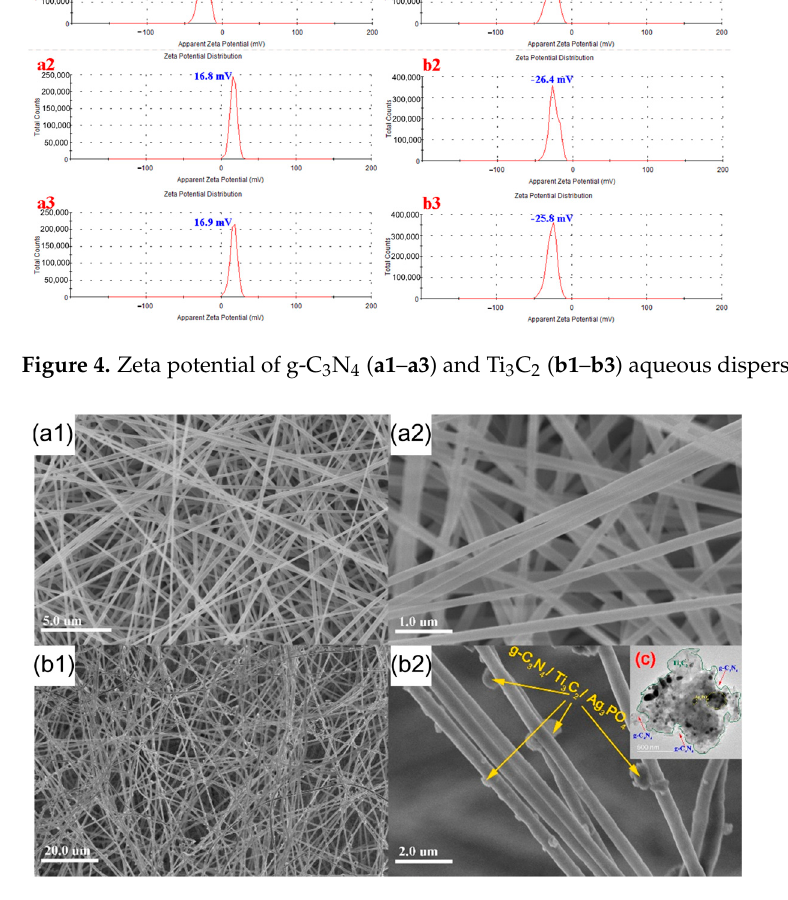
Figure 5. SEM of PAN nano fi ber ( a1 – 2 ), PAN nano fi ber composite catalytic membrane ( b1 – 2 ), TEM of g-C 3 N 4 /Ti 3 C 2 /Ag 3 PO 4 catalyst ( c ). of g-C 3 N 4 /Ti 3 C 2 /Ag 3 PO 4 catalyst ( c